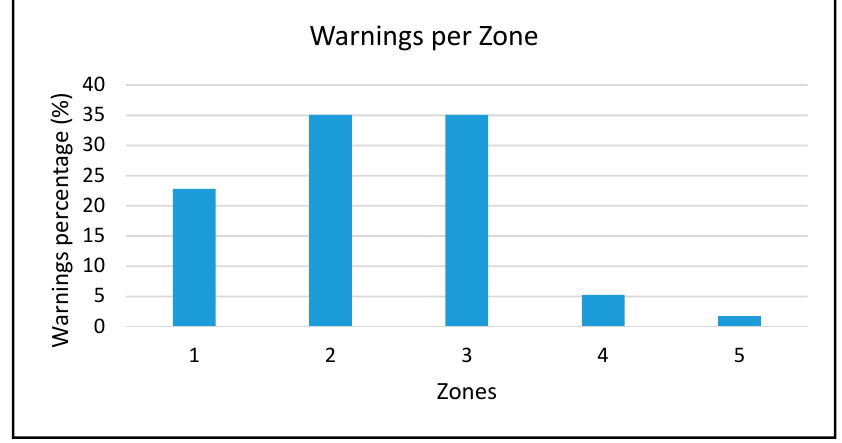
Figure 16. Percentage of warnings detected per zone.